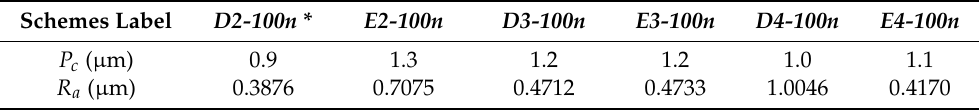
Table 2. The p c and average R a values of the samples treated with different parameter schemes. Schemes